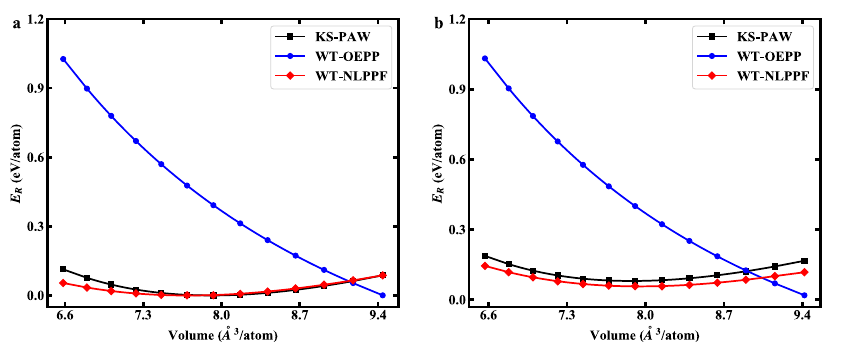
Fig. 3 Relative energy versus volume curves for Be systems. a The calculated energy-volume curves of Be-HCP. b The calculated energy-volume curves of Be-FCC. The total energy shift of WT-OEPP is − 33.030 eV/atom.